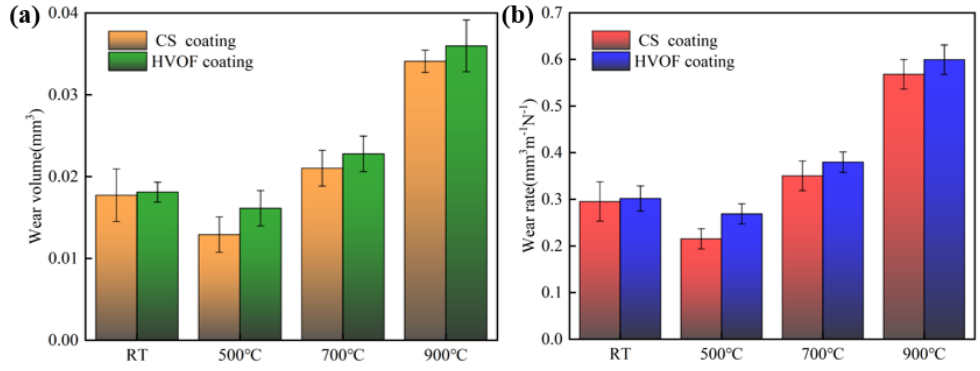
Figure 14. Wear amount and wear rate of CS and HVOF coatings heat-treated at different tempera- tures. ( a ) Wear amount; ( b ) wear rate.